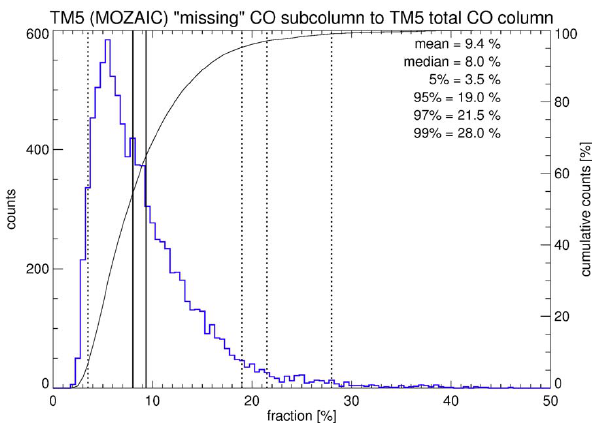
Figure 1. Probability distribution of the partial CO column “missed” by MOZAIC due to the maximum altitude of MOZAIC CO profiles based on collocated TM5 simulated CO profiles. The “missing” partial column is expressed as a fraction of the total column. Indicated are also cumulative counts, the mean and median values (solid lines) and the 5% and 95/97/99 % occurrence intervals (dashed lines).